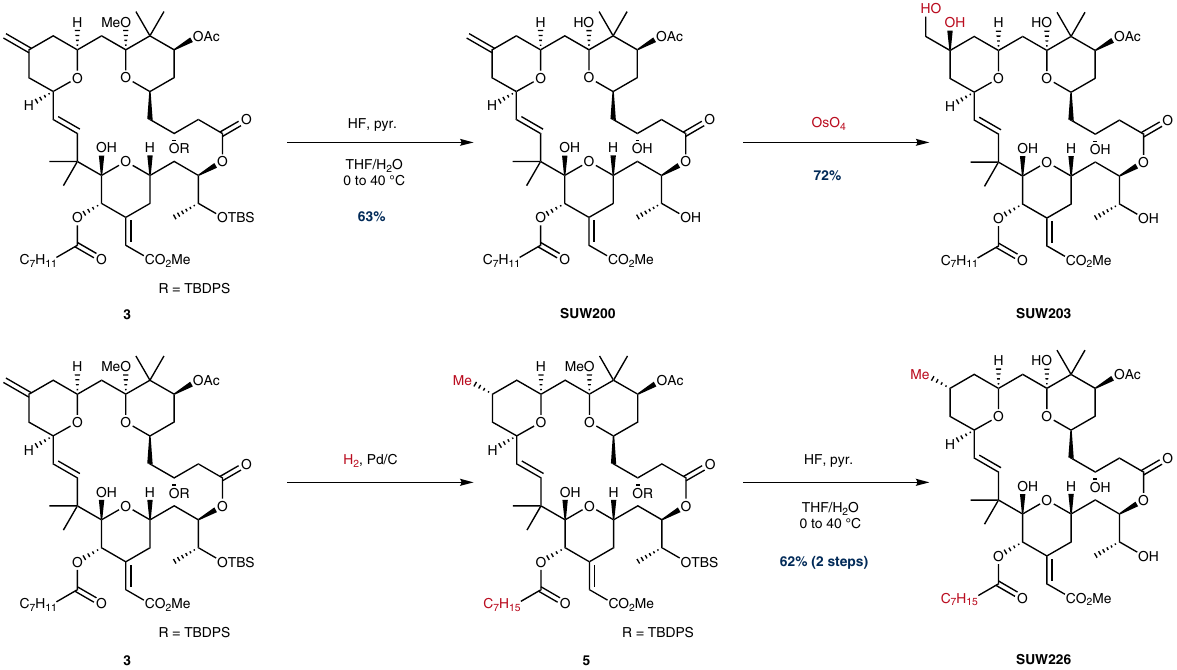
Fig. 2 Chemoselective functionalization of the C13 exo-ole fi n. Detailed procedures for speci fi c transformations can be found in the Supplementary Methods. C 7 H 11 =